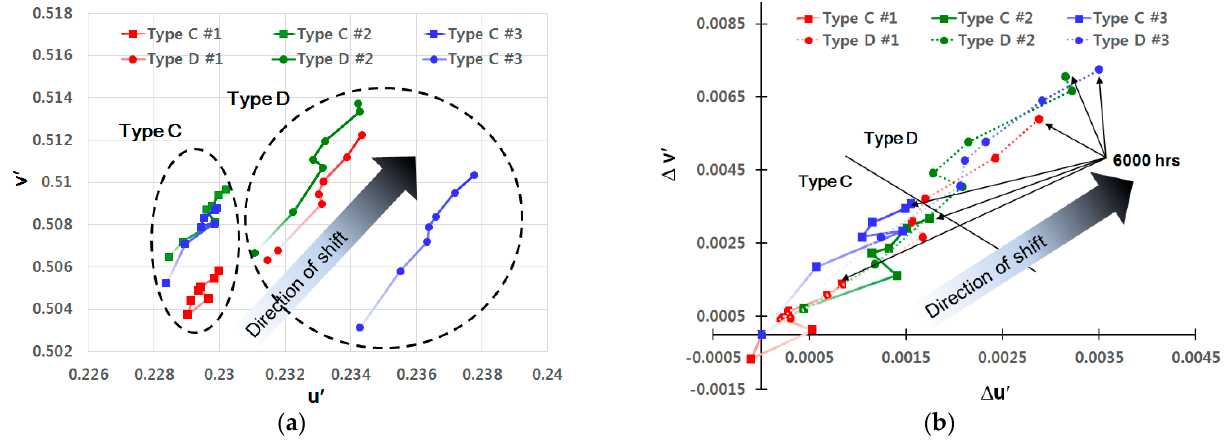
Figure 5. Color shift of OLED panel dependence on panel size. ( a ) OLED panel type C. ( b ) OLED panel type D.